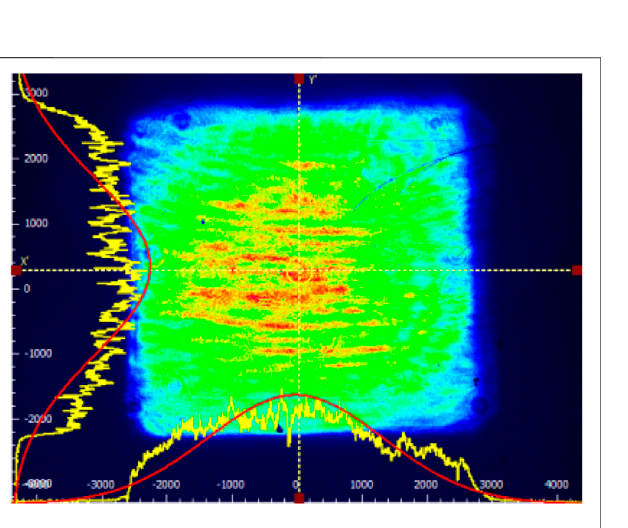
FIGURE 9 | Beam image in the near fi